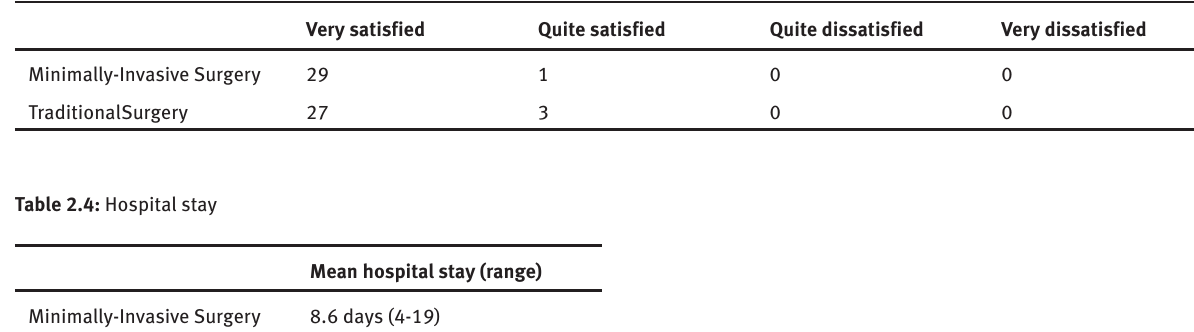
Table 2.3: Sample distribution based on satisfaction level